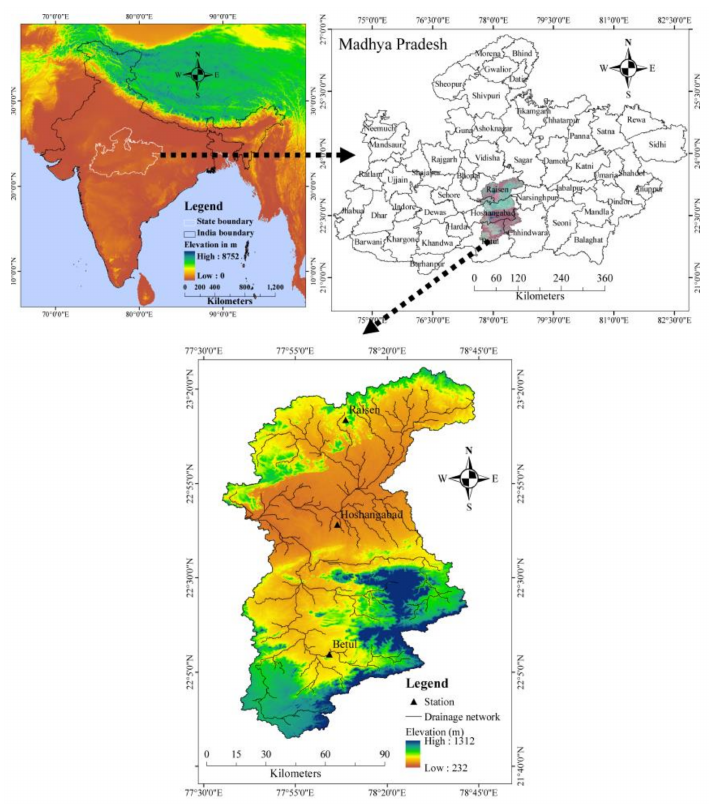
Figure 1. Location, elevation, and drainage network of the study